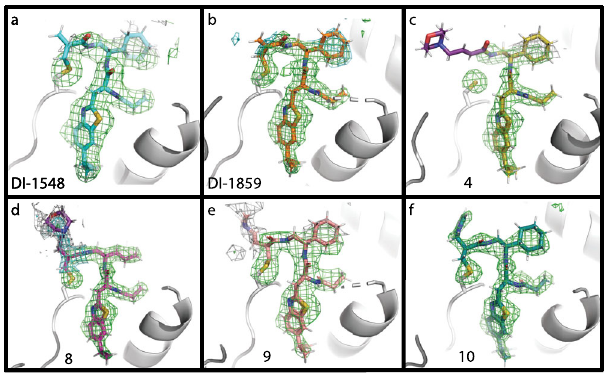
Fig. 3 Cocrystal structures of six inhibitors bound to DCN1. Omit electron density maps showing covalent binding of the compounds to DCN1 CYS S γ (yellow), except for compound 4 whose omit map shows the lack of covalent bonding. The difference electron density map for each structure was calculated omitting the coordinates of the compound and CYS S γ & C β atoms of DCN1. Contour levels for each map are a 2 σ green, 1 σ gray, b 3 σ green, 2 σ cyan, c 3 σ green, 1.3 σ gray, d 3 σ green, 1.5 σ cyan, 0.8 σ gray, e 2.5 σ green, 1 σ gray, and f 3 σ green. The ribbon of DCN1 backbone atoms are shown in gray, compounds are shown as sticks with nitrogen blue, oxygen red, sulfur yellow, and carbon for a DI-1548 (PDB ID: 6XOL), cyan, b DI-1859 (PDB ID: 6XOO), orange, c compound 4 (PDB ID: 6XOQ), gold, d compound 8 (PDB ID: 6XOM), magenta, e compound 9 (PDB ID: 6XON), pink, and f compound 10 (PDB ID: 6XOP), teal. All ligands were re fi ned with atom occupancies of 1.0, except two groups shown with plum carbon atoms: methylmorpholine group of 8 , which was re fi ned with occupancy of 0.5 and the allymorpholine group of compound 4 , which was re fi ned with an occupancy of